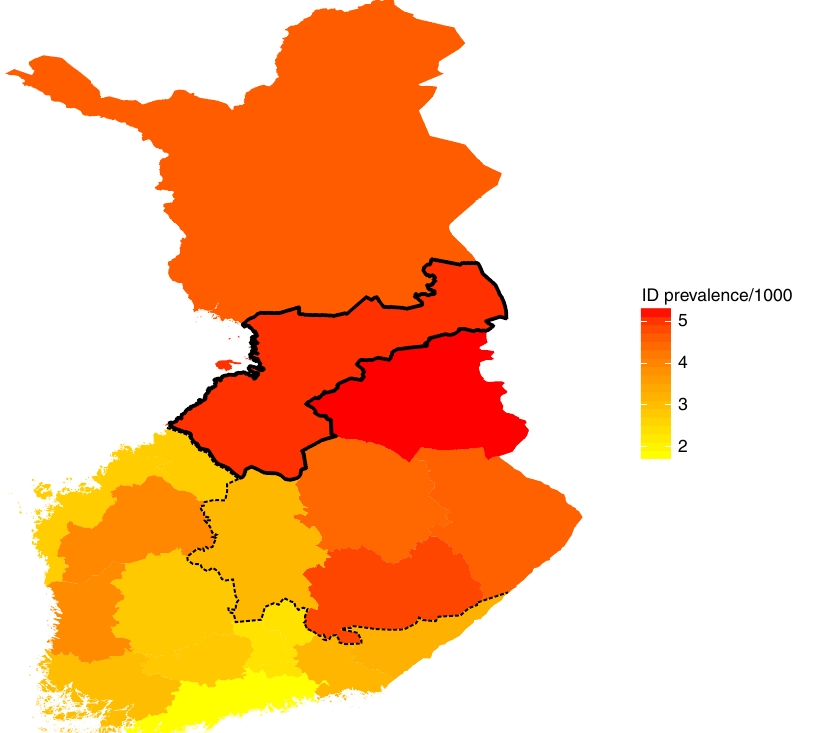
Fig. 1 ID prevalence estimates in different municipalities in Finland. The primary NFID collection municipalities of Northern Ostrobothnia, Kainuu and Lapland are outlined in solid black. The approximate boundary between early and late settlements is shown with a dashed